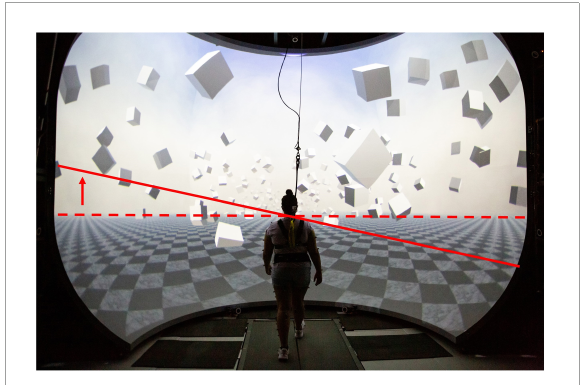
FIGURE1 Virtual Reality Environment: The solid red line shows the tilt of the horizon (dashed) during the visual fall perturbation for a left sided virtual fall. Similar degree of tilt on the opposite side was generated for a right sided